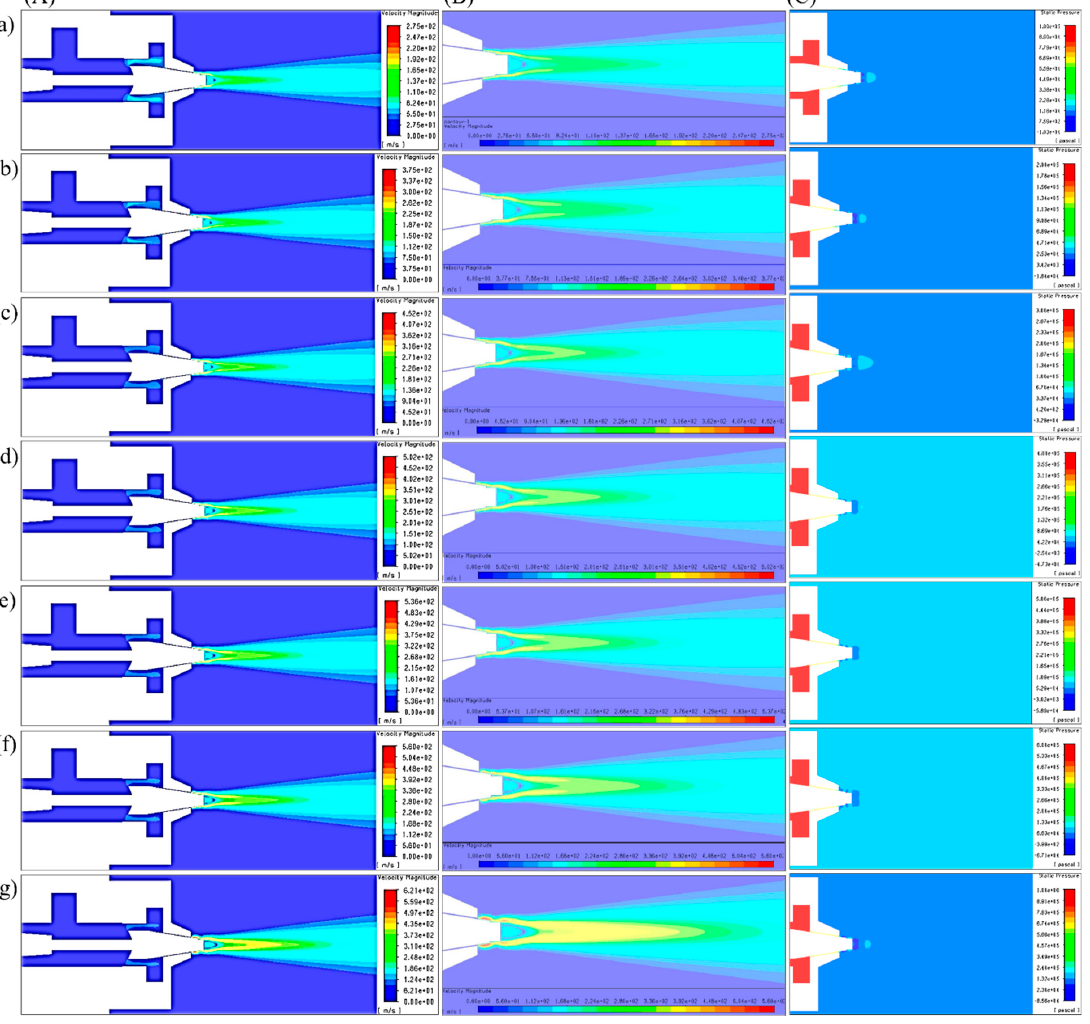
Figure 6. k- ε turbulence flow contours through SBS nozzle at different air pressures: ( A , B ) velocity (m/s), ( C ) pressure (Pa), ( a ) 1 bar, ( b ) 2 bar, ( c ) 3 bar, ( d ) 4 bar, ( e ) 5 bar, ( f ) 6 bar, ( g ) 10 bar.